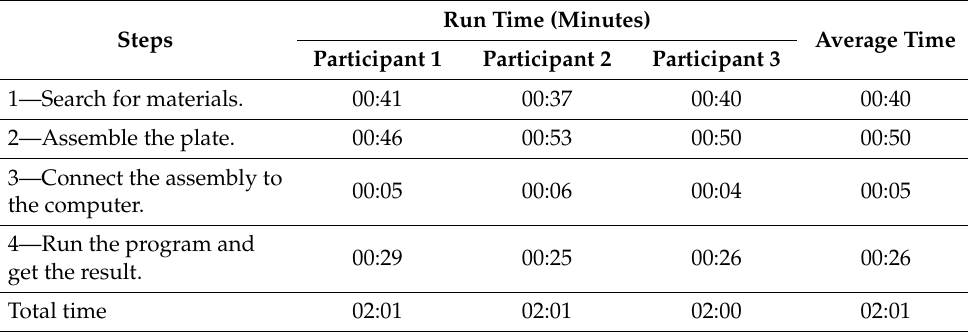
Table 3. Experimental procedure run times after the implementation of Lean